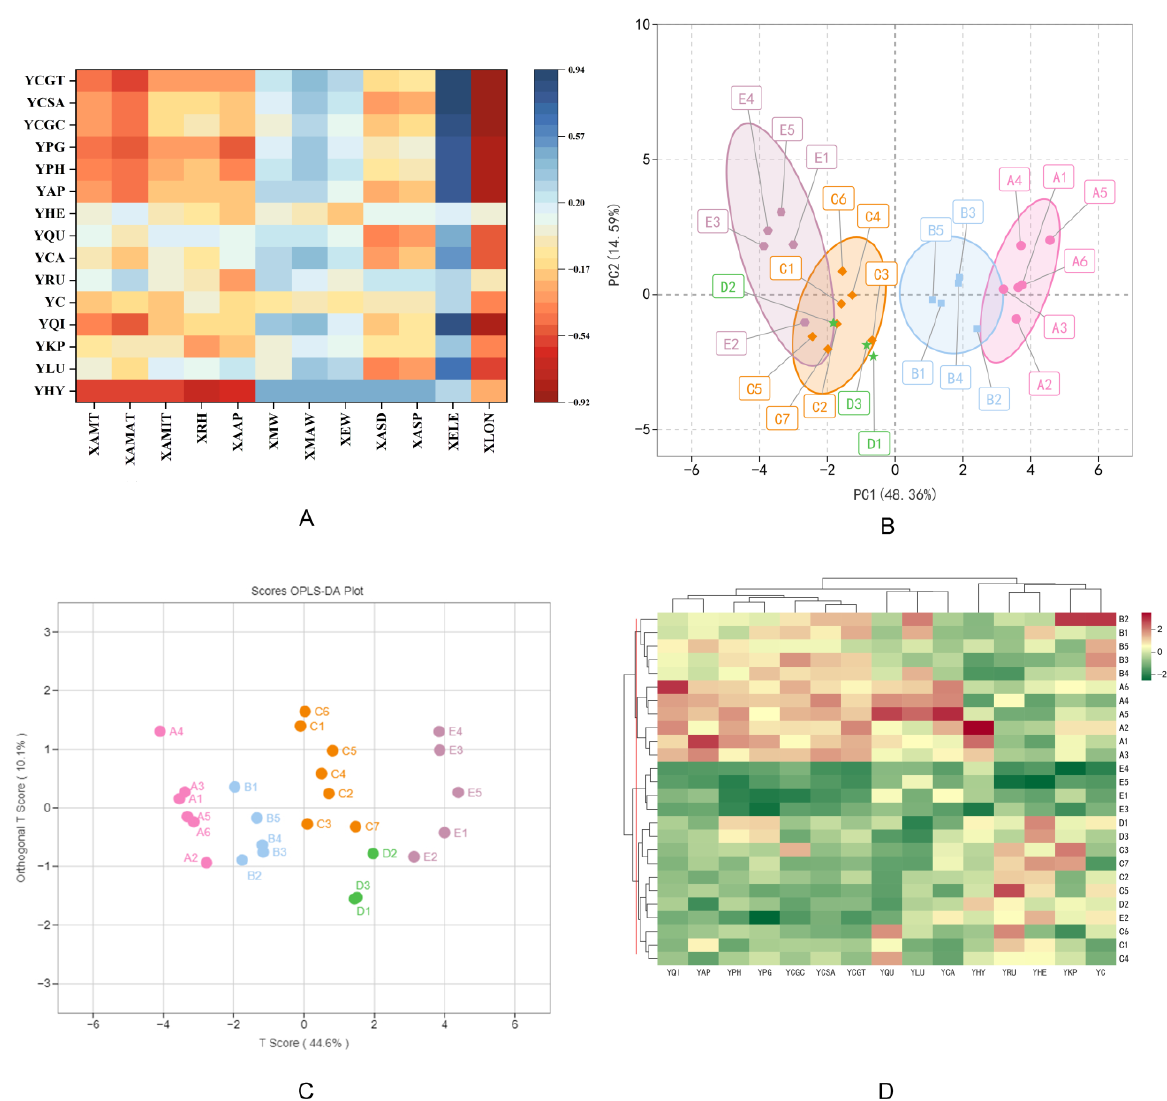
Figure 3. Geographical variation in flavonoid compounds. ( A ): Correlation coefficient analysis be- tween flavonoids content and geographical factors. ( B ): PCA on 2D plot of Chinese prickly ash based on flavonoid compound contents. Four different color ellipses represent PCA results. ( C ): Different flavonoid compounds analysis on the basis of orthogonal signal correction and partial least squares- discriminant analysis (OPLS-DA). ( D ): Cluster heatmap plot of Chinese prickly ash from